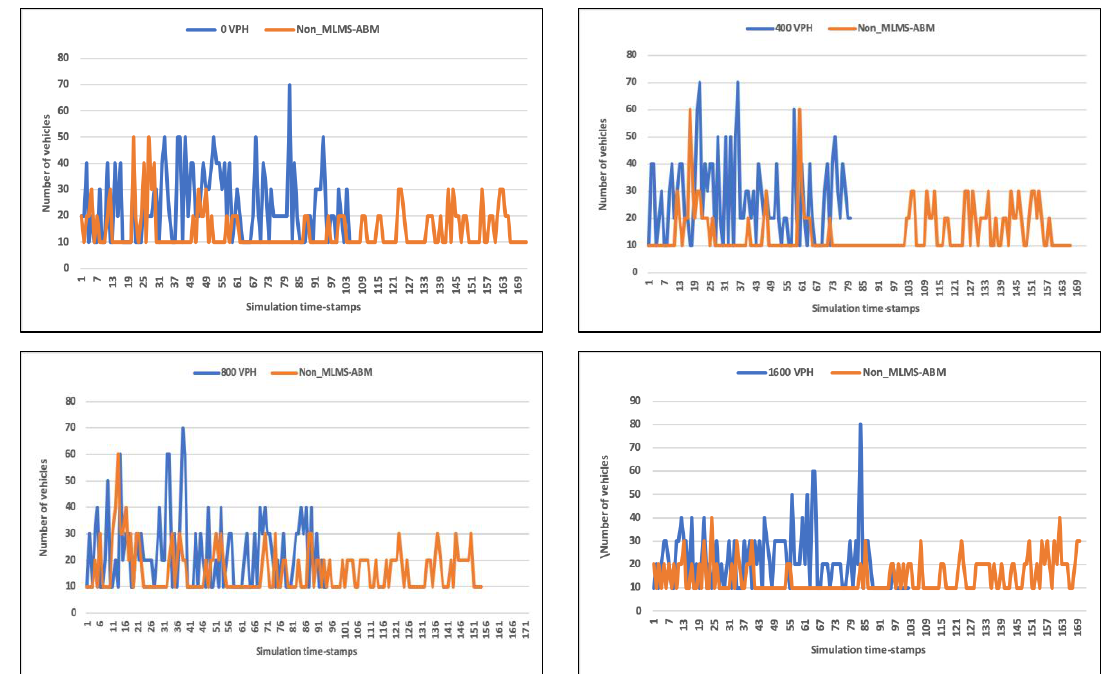
Figure 10. Tra ffi c throughput during simulation with di ff erent arterial loads. Figure 10. Traffic throughput during simulation with different arterial loads. Figure 10. Traffic throughput during simulation with different arterial loads.